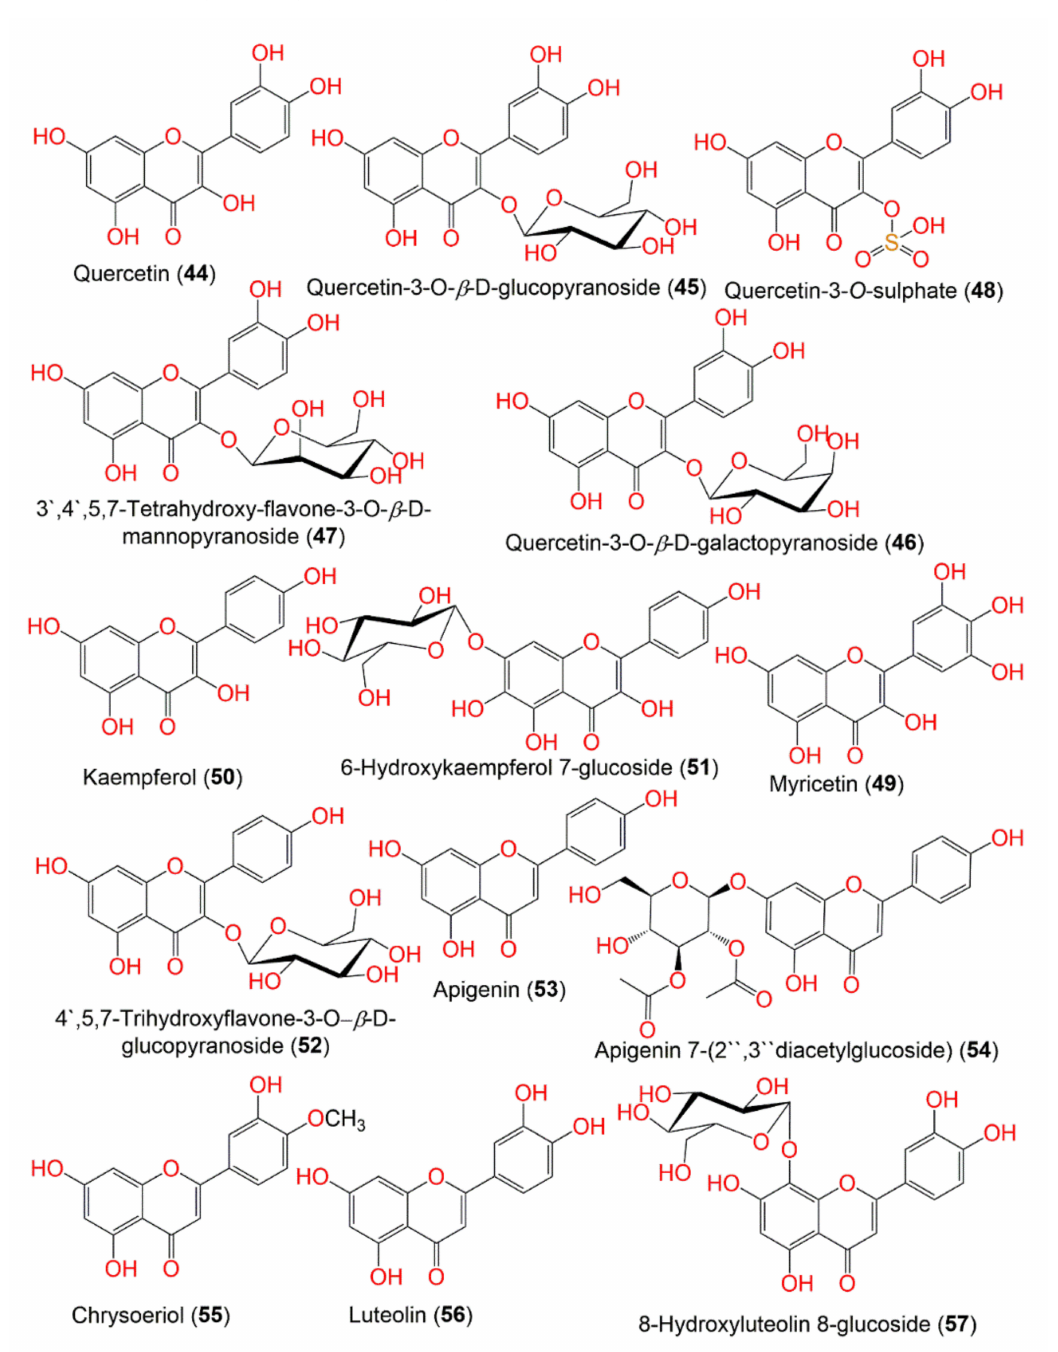
Figure 6. Structures of compounds 44 – 57